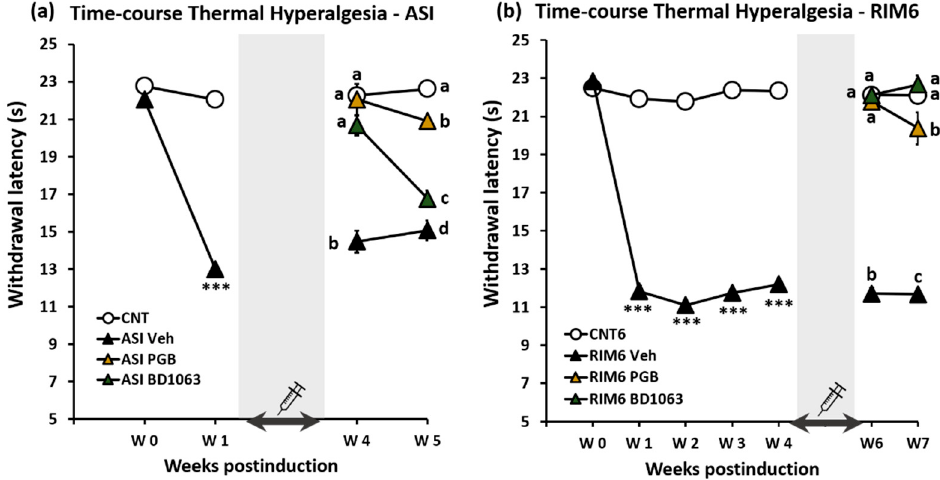
Figure 3. Effect of BD1063, pregabalin (PGB), and saline (vehicle) treatment on the thermal hyperalgesia response in RIM6 and ASI experimental models of fibromyalgia during 7 and 5 weeks postinduction, respectively. Withdrawal latency to painful thermal stimulus ( a ) in the intramuscular acid saline solution injection model (ASI) and ( b ) in the reserpine-induced myalgia model (RIM6). The shaded bar and the syringe indicate the postinduction period in which the different pharmacological treatments have been administered. *** p < 0.001 with respect to the control group. a–d: Groups not sharing a letter are significantly different p < 0.05. Each point and vertical line represent the mean ±